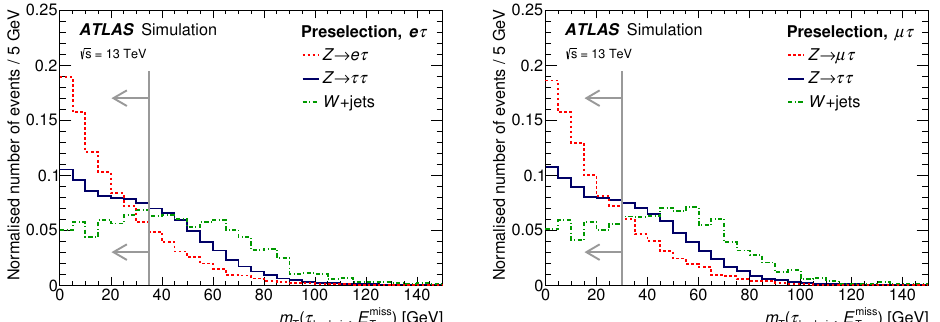
( τ ) in Z → ττ , W + jets and sig- , E miss T had-vis T